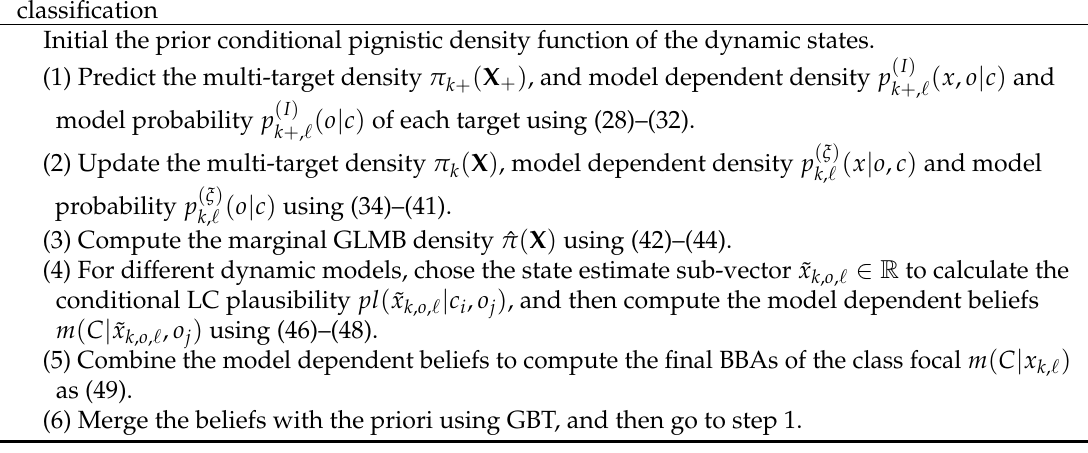
Algorithm 1: MGLMB-cTBM algorithm for multi-target joint detection, tracking and